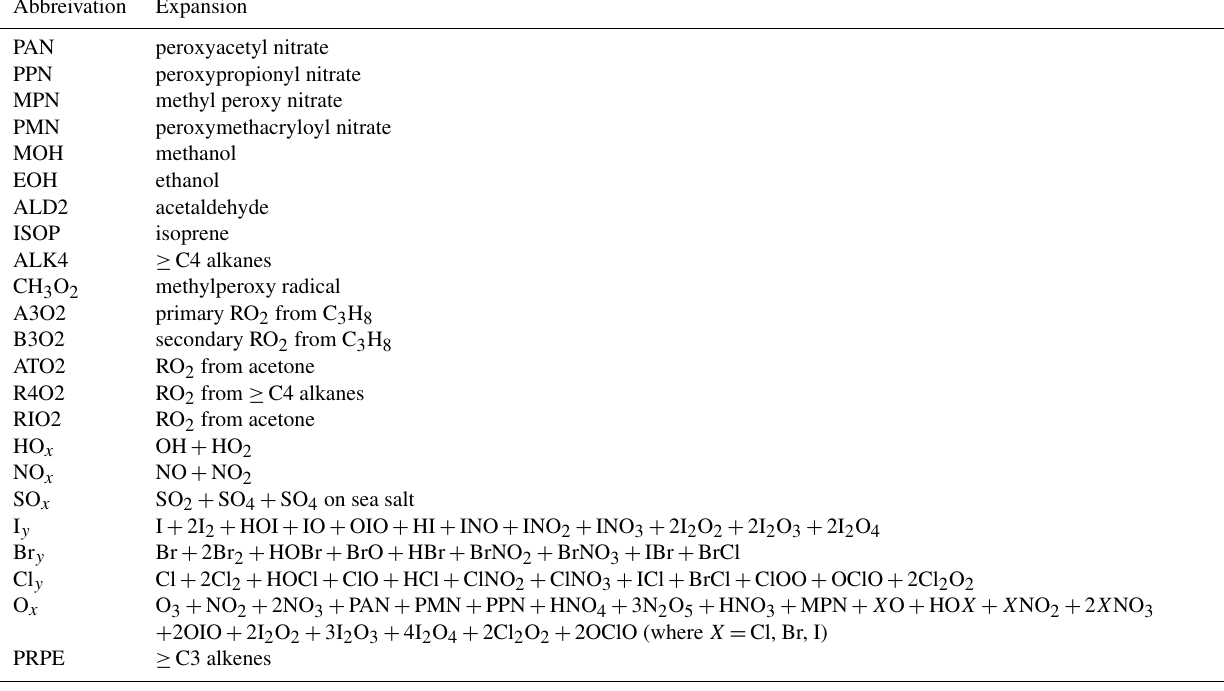
Table C1. Abbreviations used in the document. Abbreviated species names used here are defined in the GEOS-Chem manual (http://acmg.